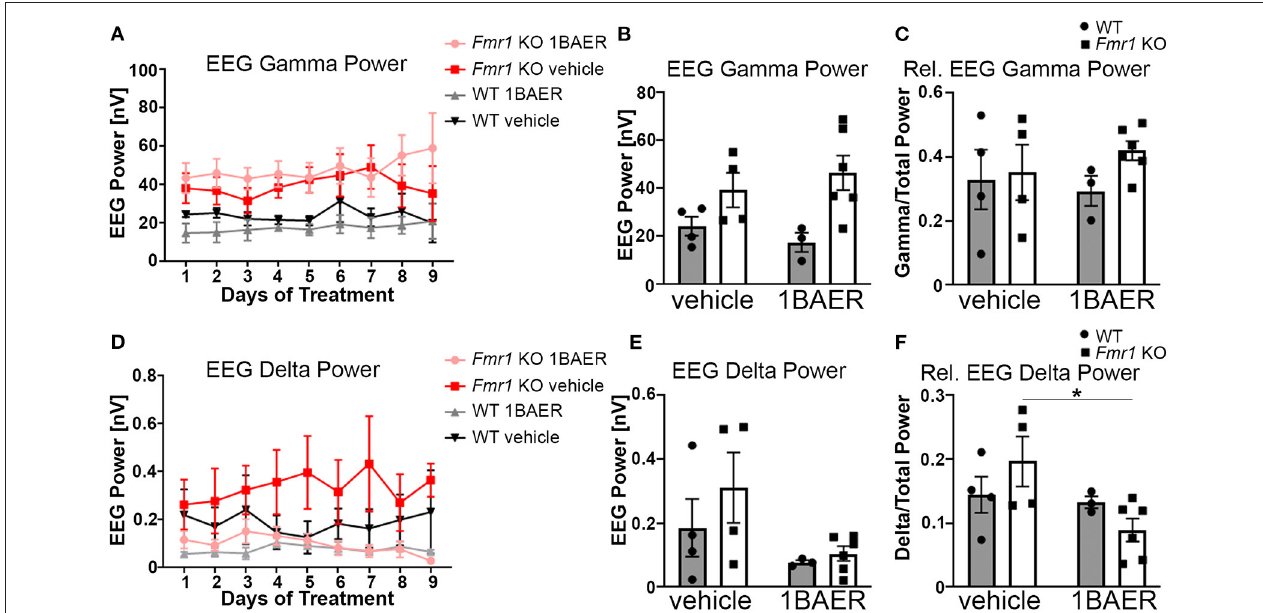
FIGURE 2 | Low-dose BAER-101 reduces increased delta EEG power but not gamma EEG power in Fmr1 KO mice. (A–C) Gamma EEG power is increased in Fmr1 KO mice but not affected by daily treatment with 1 mg/kg BAER-101 (1BAER) over 9 days. The effect of drug or genotype on absolute gamma EEG power does not change during the 9 day treatment period [ A , separated by day, mixed-effects analysis, p (genotype) = 0.007, p (day) = 0.30, p (day x treatment) = 0.72; p (day x genotype) = 0.99, p (day x treatment x genotype) = 0.80; no other significant effects; (B) , 9-day average, 2-way ANOVA, p (treatment) = 0.98, p (genotype) = 0.007, p (interaction) = 0.33]. Relative gamma power (normalized to the EEG power across all frequency bands) shows on average non-significantly increased power in Fmr1 KO mice compared with WT [ C , 9-day average, 2-way ANOVA, p (treatment) = 0.81, p (genotype) = 0.29, p (interaction) = 0.45]. (D–F) Delta EEG power is reduced by daily treatment with 1 mg/kg BAER-101 over 9 days. Similarly as for gamma EEG power, the effect of drug or genotype on absolute delta power does not change over the 9-day period [ D , separated by day, mixed-effects analysis, p (treatment) = 0.047, p (day) = 0.58, p (day x treatment) > 0.99; p (day x genotype) = 0.40, p (day x treatment x genotype) = 0.31; no other significant effects; (E) 9-day average, 2-way ANOVA, p (treatment) = 0.045; p (genotype) = 0.30, p (interaction) = 0.50]. Relative delta power in Fmr1 KO is significantly reduced by 1 mg/kg BAER-101 whereas no effect on WT was observed [ F , 2-way ANOVA with Sidak’s post-hoc